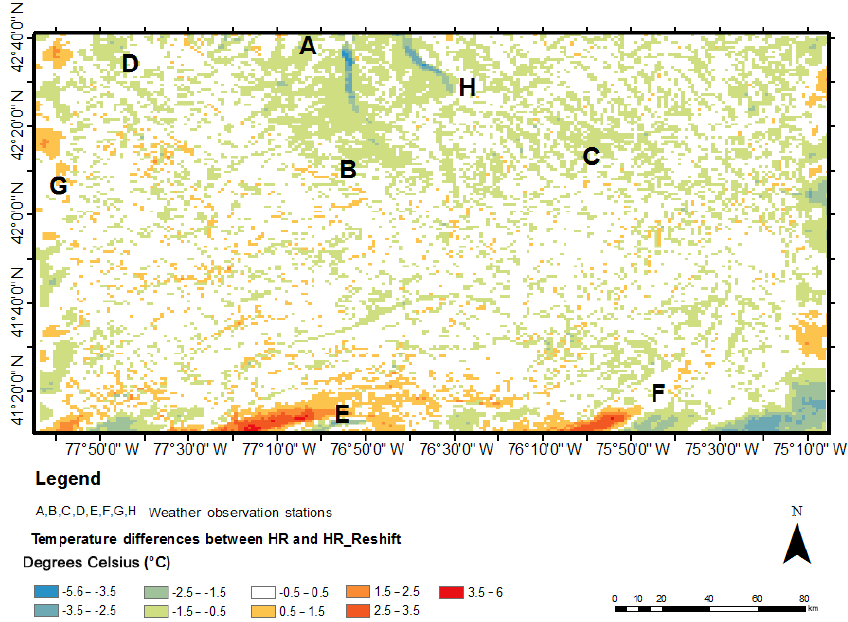
Figure 10. Temperature difference between HR and HR_RESHIFT on 14 May 15:00EST, 2015, showed that there is no significant spatial